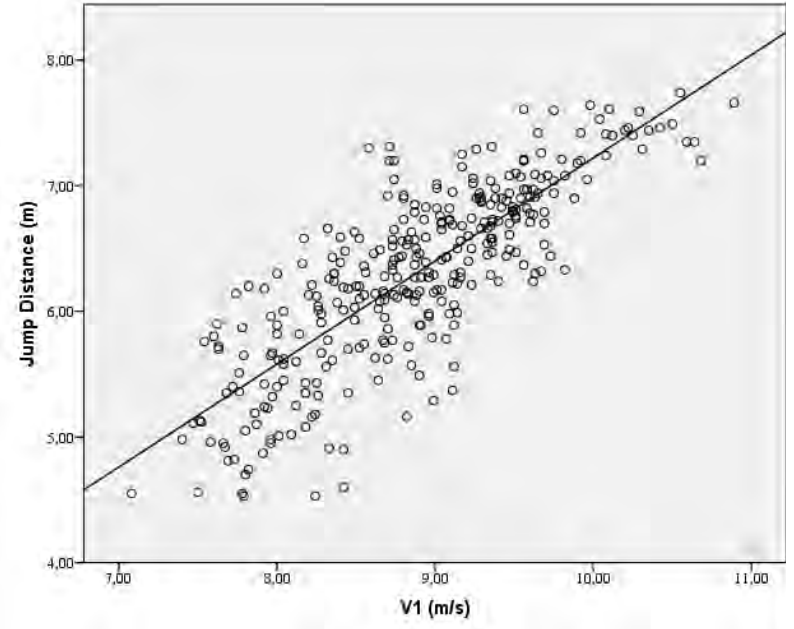
Figure 2. The relationship between the approach run-up velocity which is V1 (11-6 m) and official jump distance (r=0.81, p<0.05; r 2